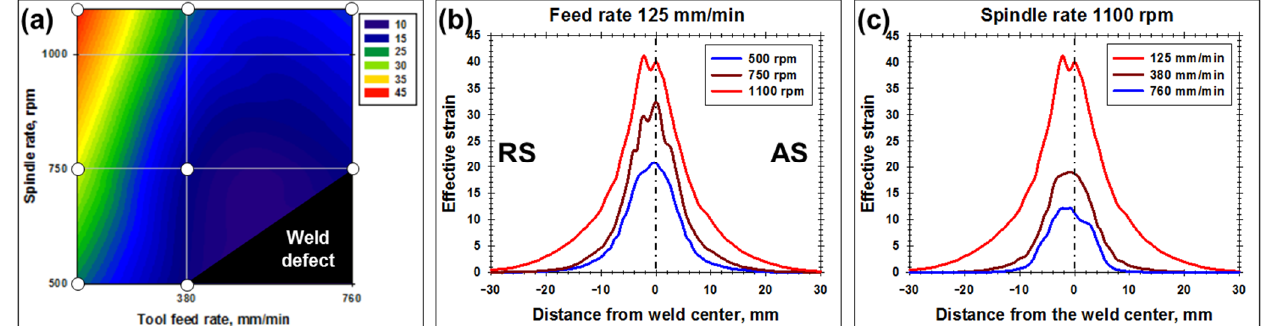
Figure 7. The combined effect of welding variables on the peak strain ( a ), and typical effect of spindle rate ( b ) and the tool feed rate ( c ) on the strain profiles calculated across the weld mid-thickness. In all cases, the strain data were simulated for the weld section behind the shoulder edge. In ( a ), circles indicate the welding conditions for which the strain data were actually simulated. In ( b ), the data for the welds produced at the feed rate of 125 mm/min are shown. In ( c ), the data for the welds produced at the spindle rate of 1100 rpm are shown.